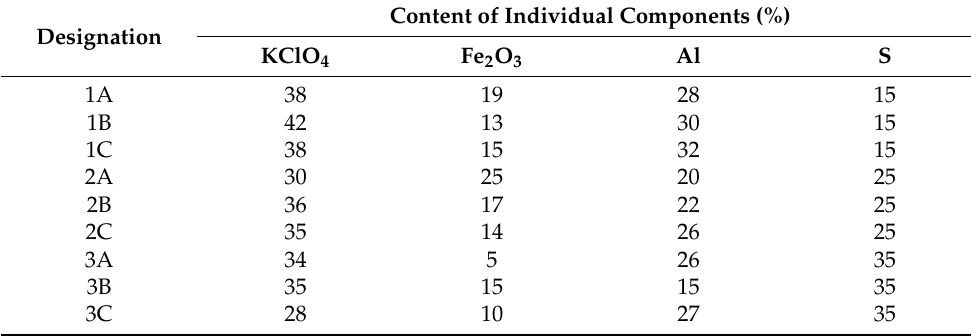
Table 1. The percentage content of components of prospective pyrotechnic compositions from the M-1 group, obtained using mathematical modelling [16].